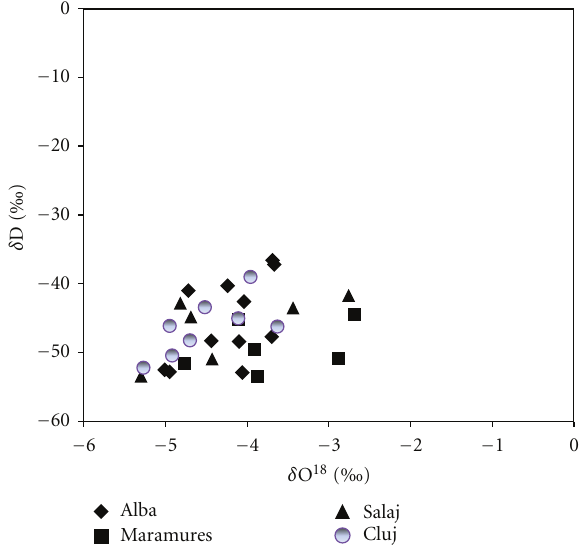
Figure 1: δ 18 O versus δ D plot for investigated apple